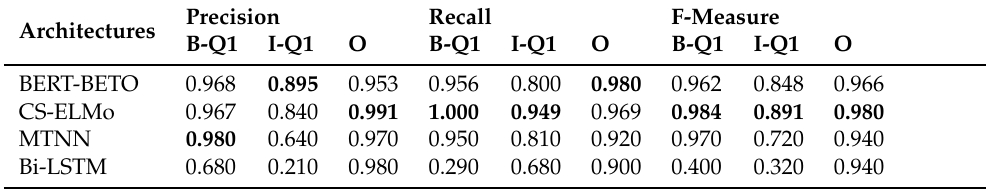
Table 1. Results for question Q1: What will you do?